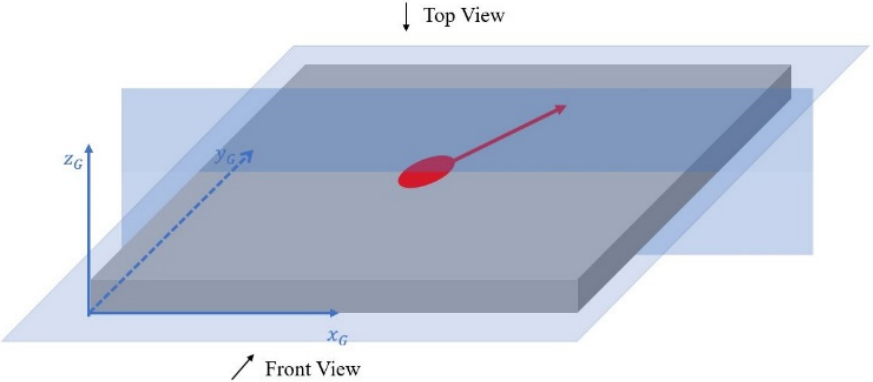
Figure 5. Illustration of the top and front view of prediction.